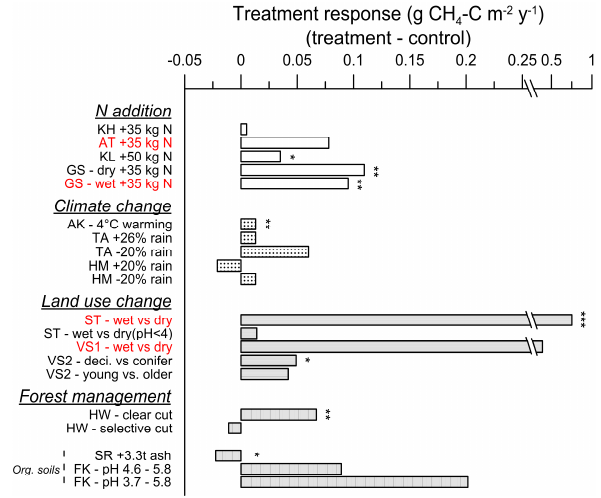
Fig. 2. Response of N 2 O gas exchange to forest change (treatment minus control). Site codes and treatments are explained in Table 1. Stars indicate the level of significance for the treatment effect ( ∗ : p < 0 . 05; ∗∗ : p < 0 . 01; ∗∗∗ : p < 0 . 001).